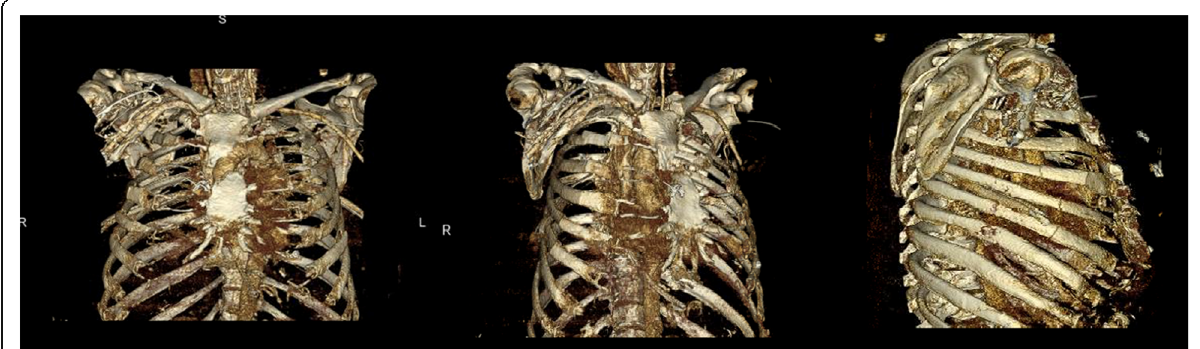
Fig. 2 3D reconstruction of the anterior chest wall (rotational views) showing on the AP panel displaced sternal fracture, disruption of the sternochondral junctions in both the right and the left, on the oblique panel significant diastasis of the sternochondral junctions on the right side and multiple fractures of the second though sixth rib on the right side are demonstrated. Finally on the lateral panel showing a flail segment (two fractures on three consecutive ribs) between the third and the sixth rib